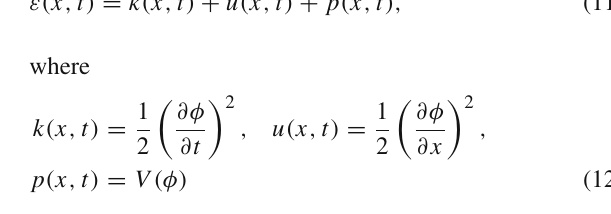
Fig. 2 Kinks(monotonouslyincreasingfunctions φ (monotonously decreasing functions φ ¯ different values of the parameter R